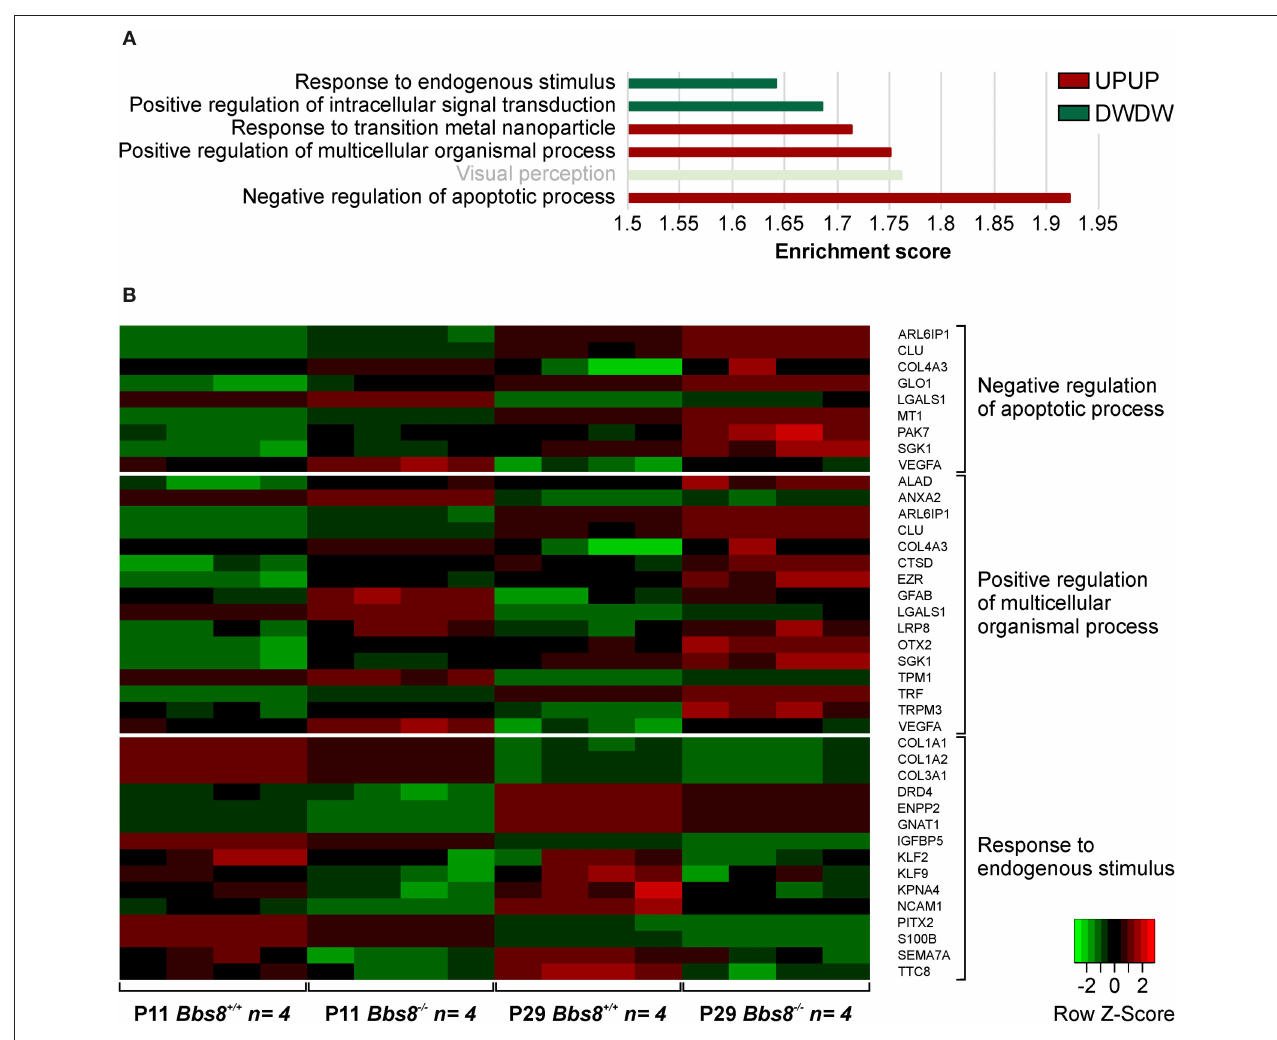
FIGURE 4 | GOEA of commonly regulated DEGs from Bbs8 − / − RPE at P11 and P29. (A) We identified three clusters of Biological processes (BP) that were significantly up-regulated and three that were significantly down-regulated at both time points. Terms are ranked according to the Enrichment score of each BP cluster. Light bright green bar denotes photoreceptor-specific genes. DW, down-regulated; UP, up-regulated. (B) Heatmap of differentially regulated genes associated with processes in